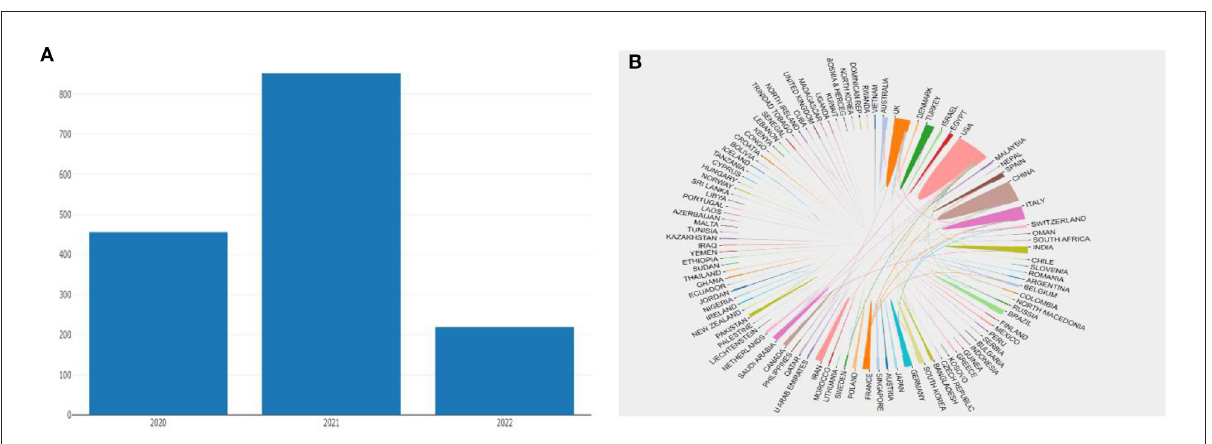
Figure 2B. The low density of the national research network map indicates that the research team is relatively independent and underlines the need for more collaboration (Table